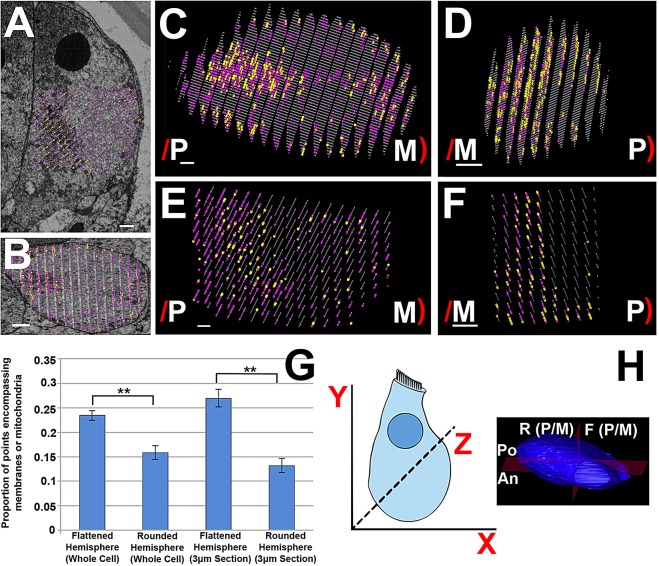
Distribution of membranes and mitochondria revealed by stereology analysis of IHCs. (A,B) Stereology grid superimposed on an image of cell 2, showing the longitudinal (A) and radial (B) section. (C,D) Stereology models of whole cells (cell 2 and cell 8). (E,F) 3-µm sections around the nucleus of the same cells. The flattened side of the cell is indicated by ‘/’ and rounded side by ‘)’; P and M indicate pillar and modiolar orientation, respectively. The concentration of membranes and mitochondria (pink and yellow) to the flattened side of the cell is visible. (G) Mean±s.e.m. distribution of membranes and mitochondria between flattened and rounded hemispheres of the IHC in 3-µm sections and whole-cell reconstructions (n=9 and n=11, respectively). (H) Orientation of the IHC on the x-, y- and z-axes, and orientation of division along the anterior-posterior axis (An and Po) and the rounded-flattened axis (R and F). The sides of this axis can be pillar or modiolar (P/M) depending of the orientation of the cell in the organ of Corti. Scale bars: 2 µm. See also supplementary material Table S1.